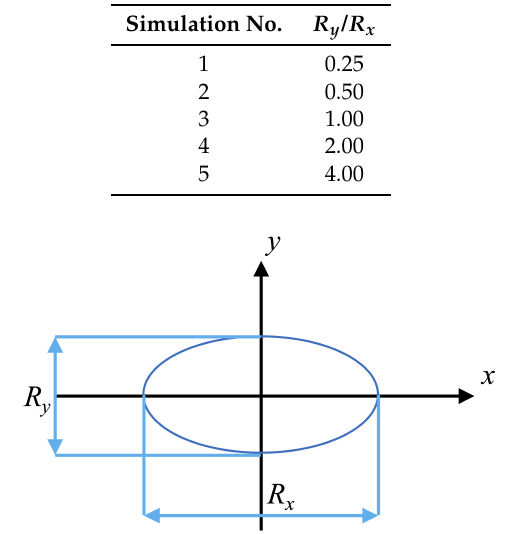
Table 4. Aspect ratio configurations for ellipsoidal obstacle: Fr = 0.6865 and Re = 1000.